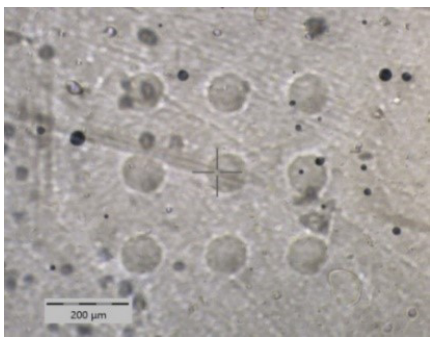
Figure 1. Optical microscopy image of indented EVA surface.